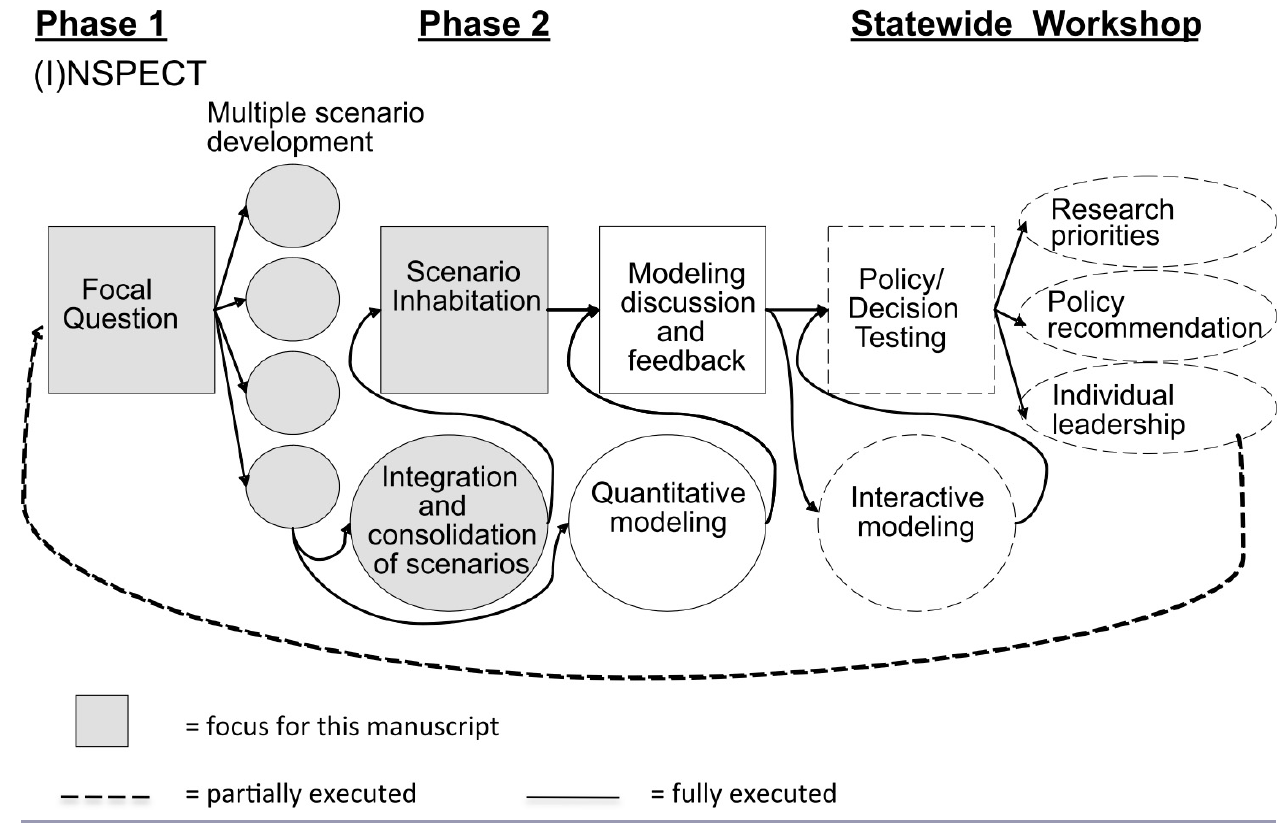
Fig. 2 . The MN 2050 scenario process. Gray shading highlights the elements of the process that are discussed in this paper. Other papers focus on the interplay between qualitative scenarios and quantitative modeling (Schmitt Olabisi et al. 2010) and on the design and effectiveness of the overall learning system (Kapuscinski et al. unpublished manuscript